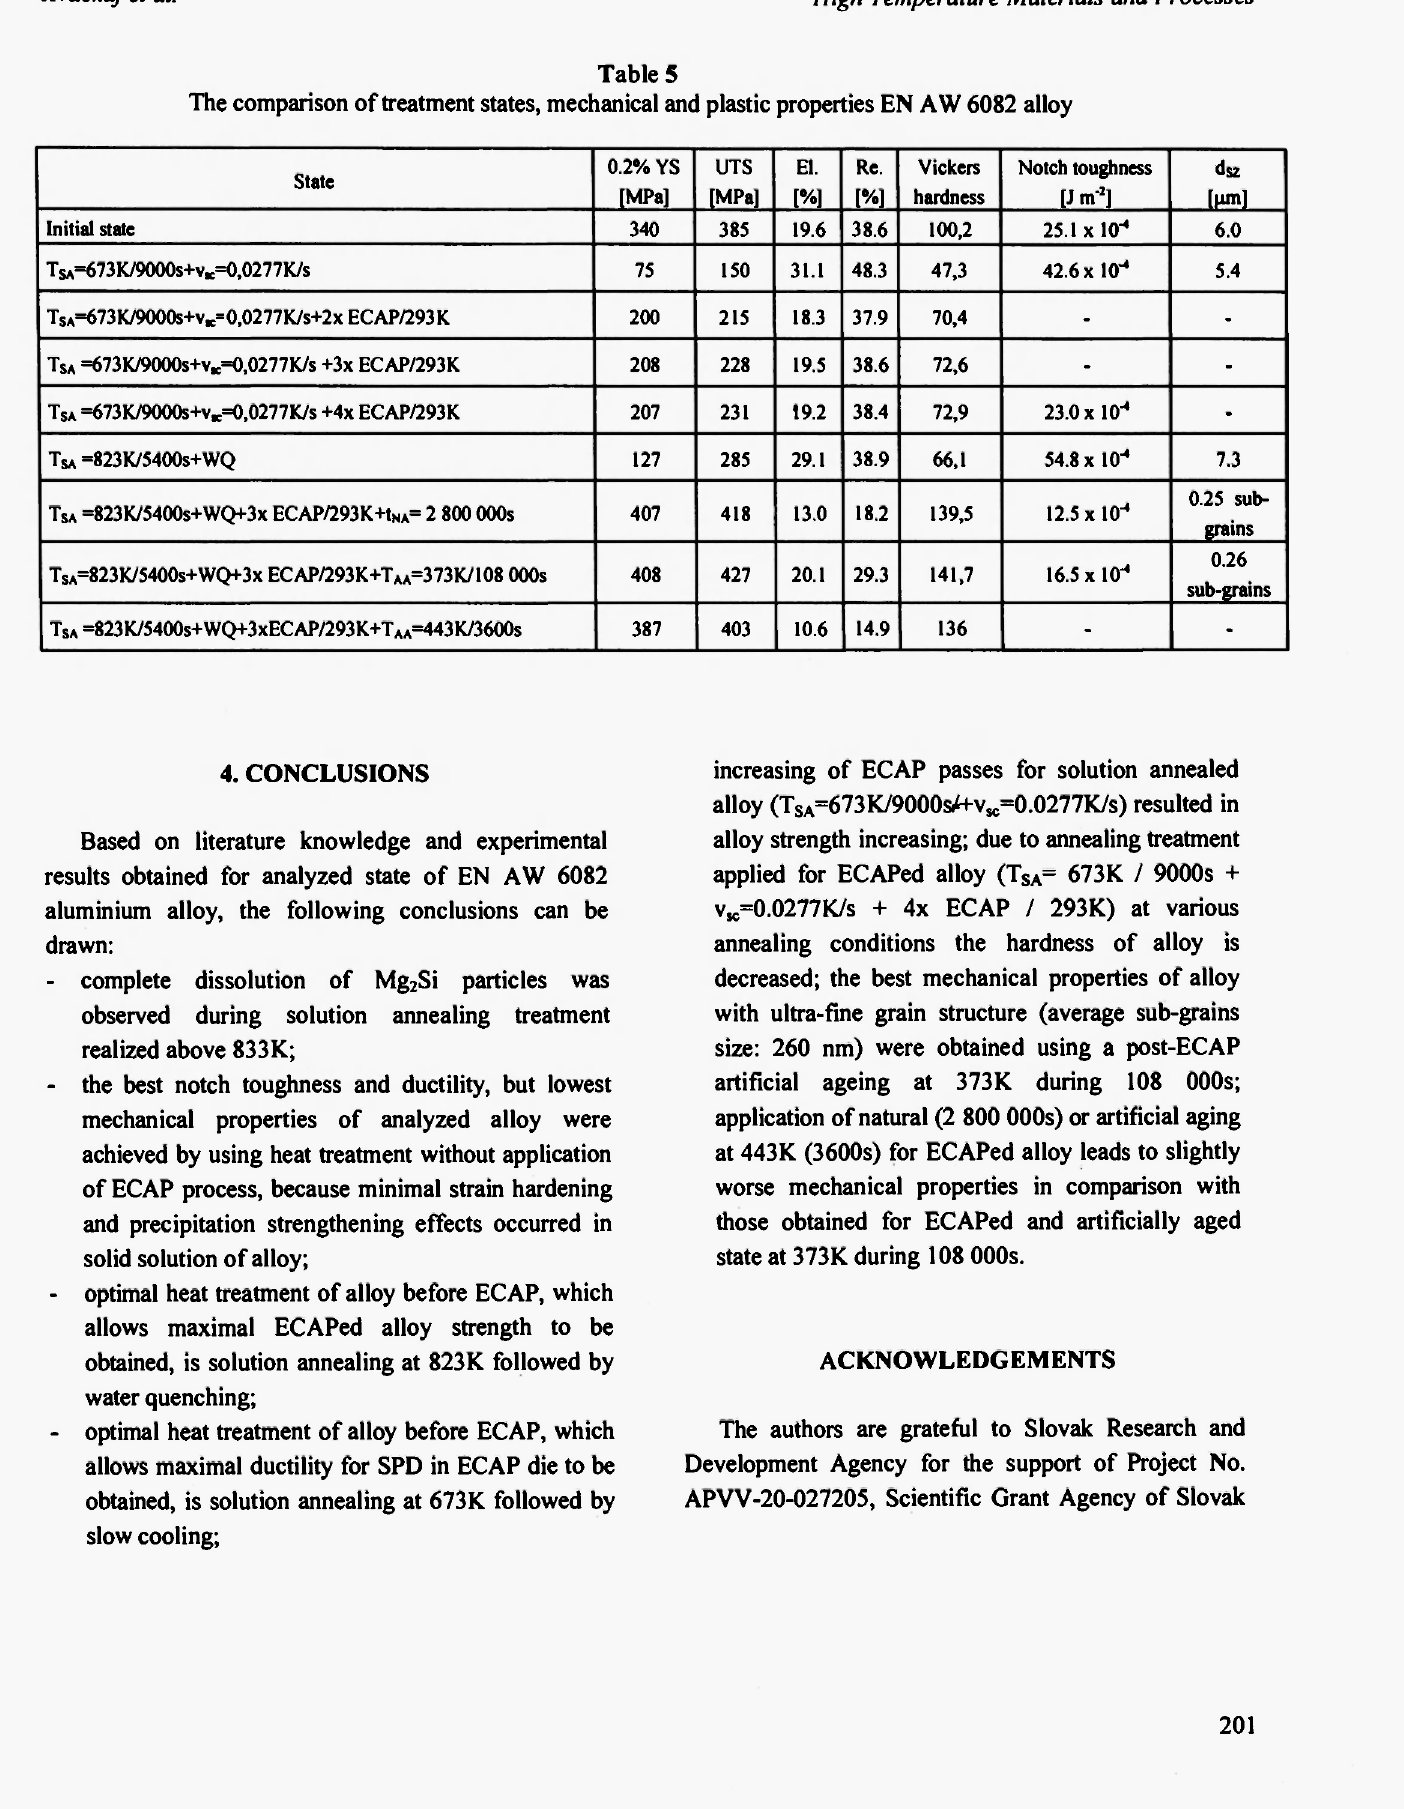
The comparison of treatment states, mechanical and plastic properties EN AW 6082